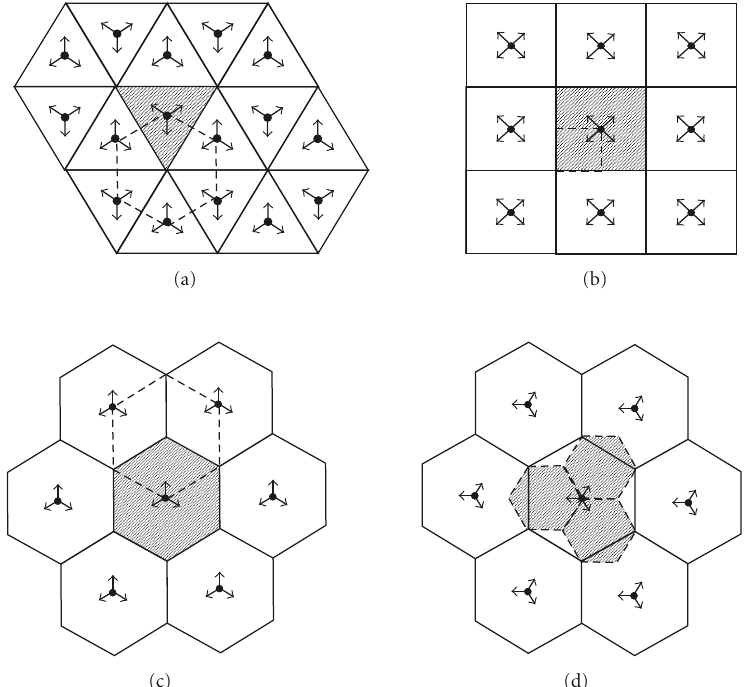
Figure 1: Triangle, square, and hexagon-based cellular network layouts. (a) Triangle, (b) square, (c) hexagonal, and (d) clover-leaf layouts.